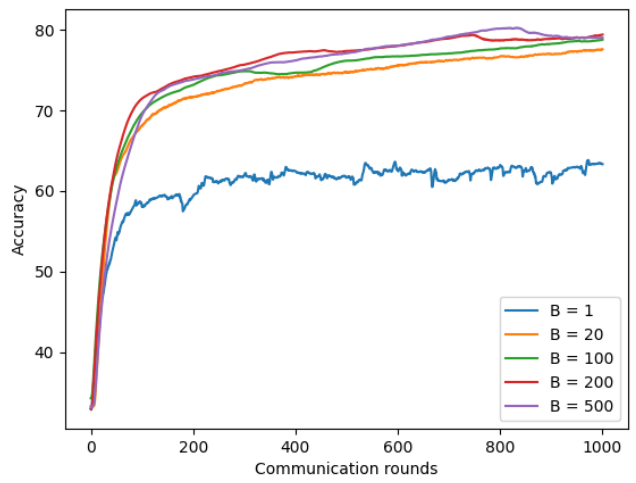
Figure 14. Non-IID with different batch-size based on chest X-ray